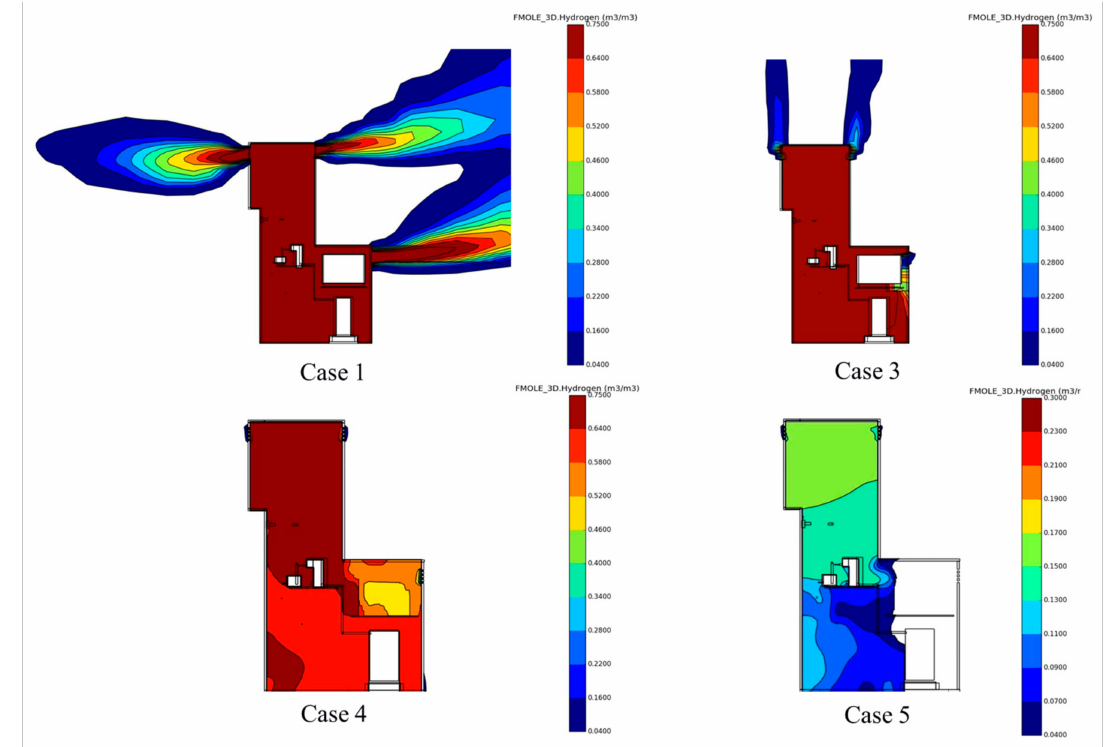
Figure 7. Comparison of the volume fraction after leakage stopped for 3 s ( t = 8